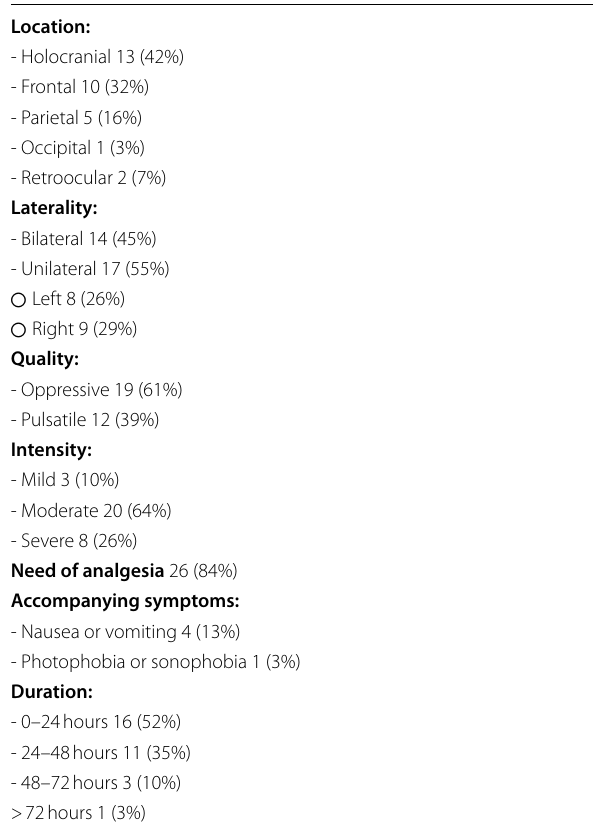
Table 2 Headache characteristics in headache related to